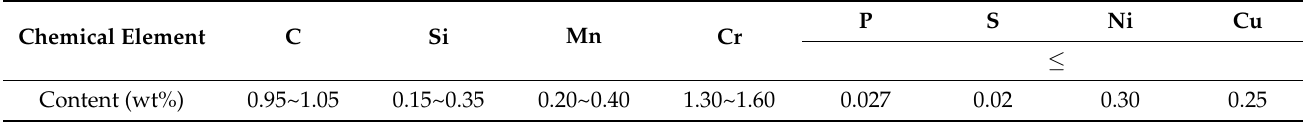
Table 1. Chemical element composition of GCr15 steels.